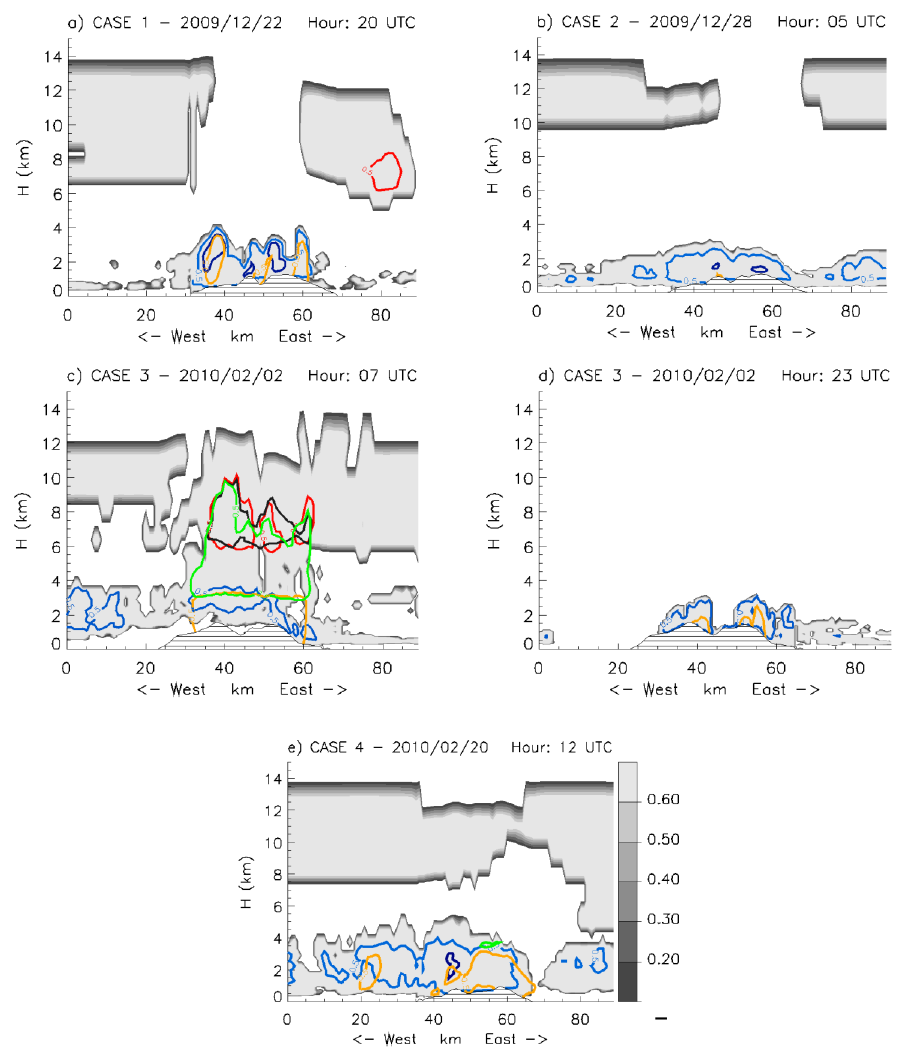
Figure 12. Vertical cross-section of mixing ratio simulations for cloud water (MRC; blue lines of 0.5gkg − 1 and dark blue lines of 1.5gkg − 1 ), rain (MRR; yellow lines of 0.5gkg − 1 ), ice (MRI; red lines of 0.5gkg − 1 ), snow (MRS; black lines of 0.5gkg − 1 ) and graupel (MRG; green lines of 0.5gkg − 1 ), as well as the cloud fraction (shaded areas). (a) 22 December 2009 – at 20:00UTC and cross-section in y = 27.7; (b) 28 December 2009 – at 05:00UTC and cross-section in y = 26; (c) 2 February 2010 – at 07:00UTC and cross-section in y = 34; (d) 2 February 2010 – at 23:00UTC and cross-section in y = 34; and (e) 20 February 2010 – at 12:00UTC and cross-section in y = 25.